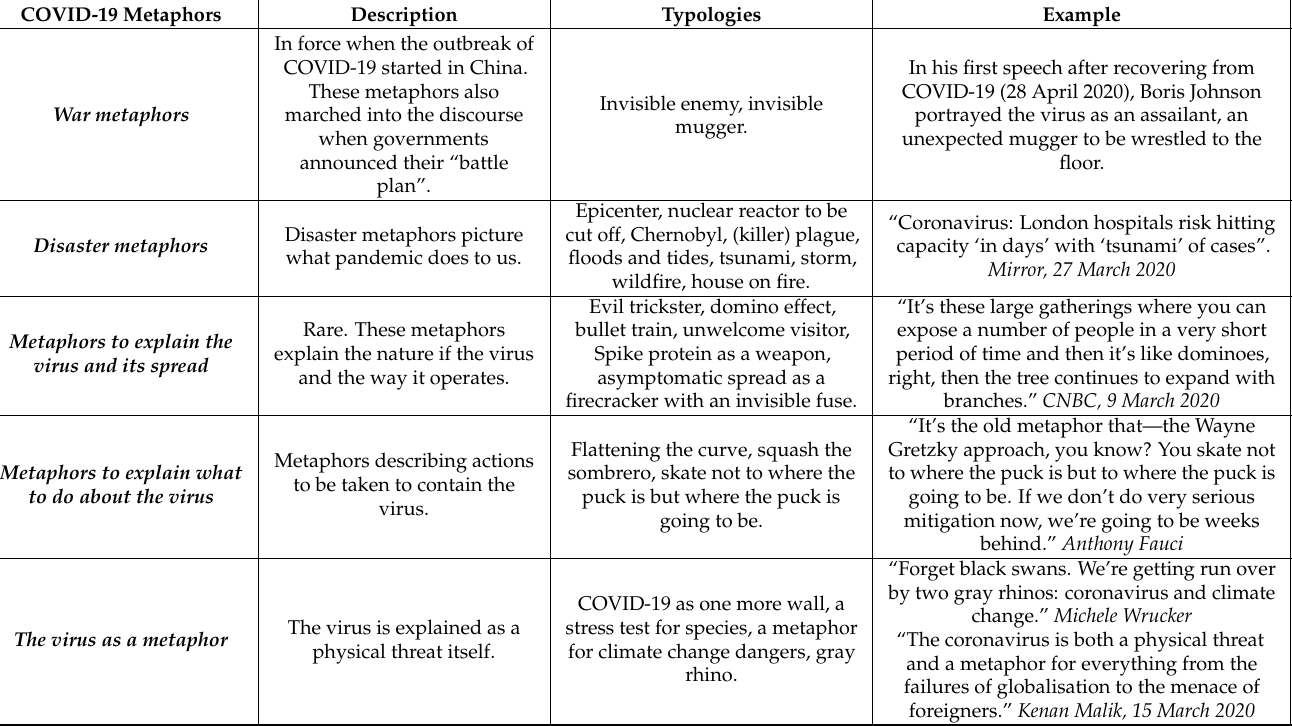
Table 1. War metaphors, grey rhinos 1 , and COVID-19 metaphorical